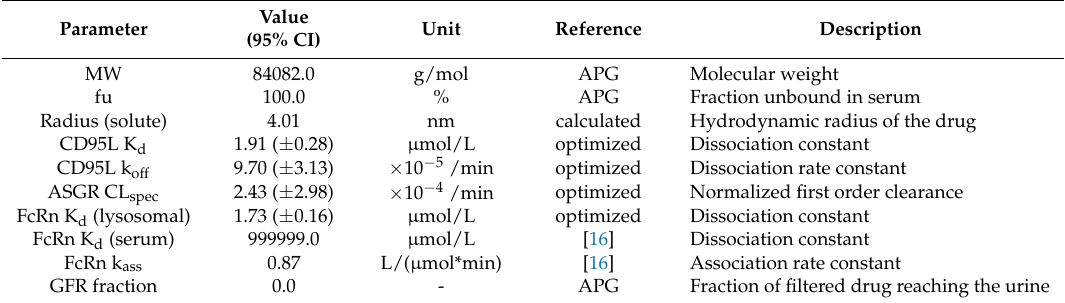
Table 2. Drug-dependent parameters of the final PK-Sim asunercept protein model.